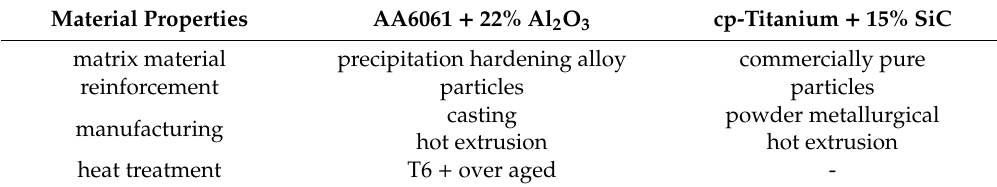
Table 1. Investigated